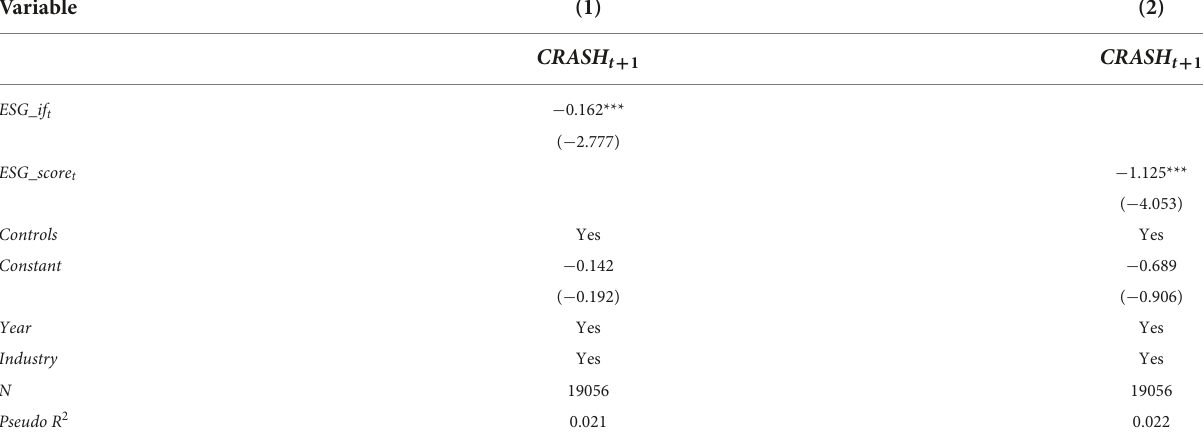
TABLE 5 Sensitivity tests for dependent variables.